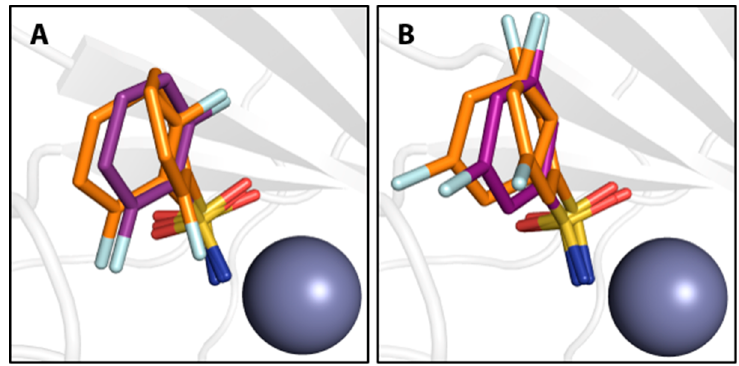
Figure 3. Compounds 8 ( A ) and 9 ( B ) in orange compared with ligand conformations observed in previously determined PDB entries 1IF5 and 1IF6 (purple), respectively. The Zn II cofactor is shown as gray sphere.